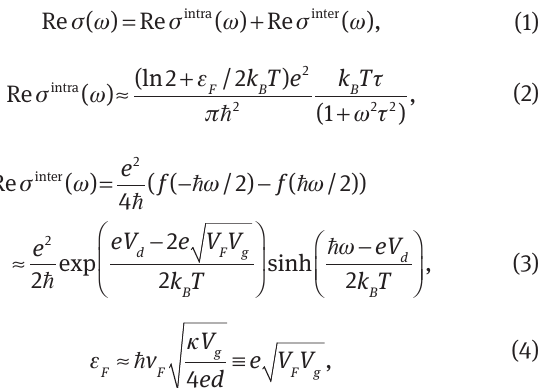
= 2 μ m, L = 15 μ sg, dg g1,2